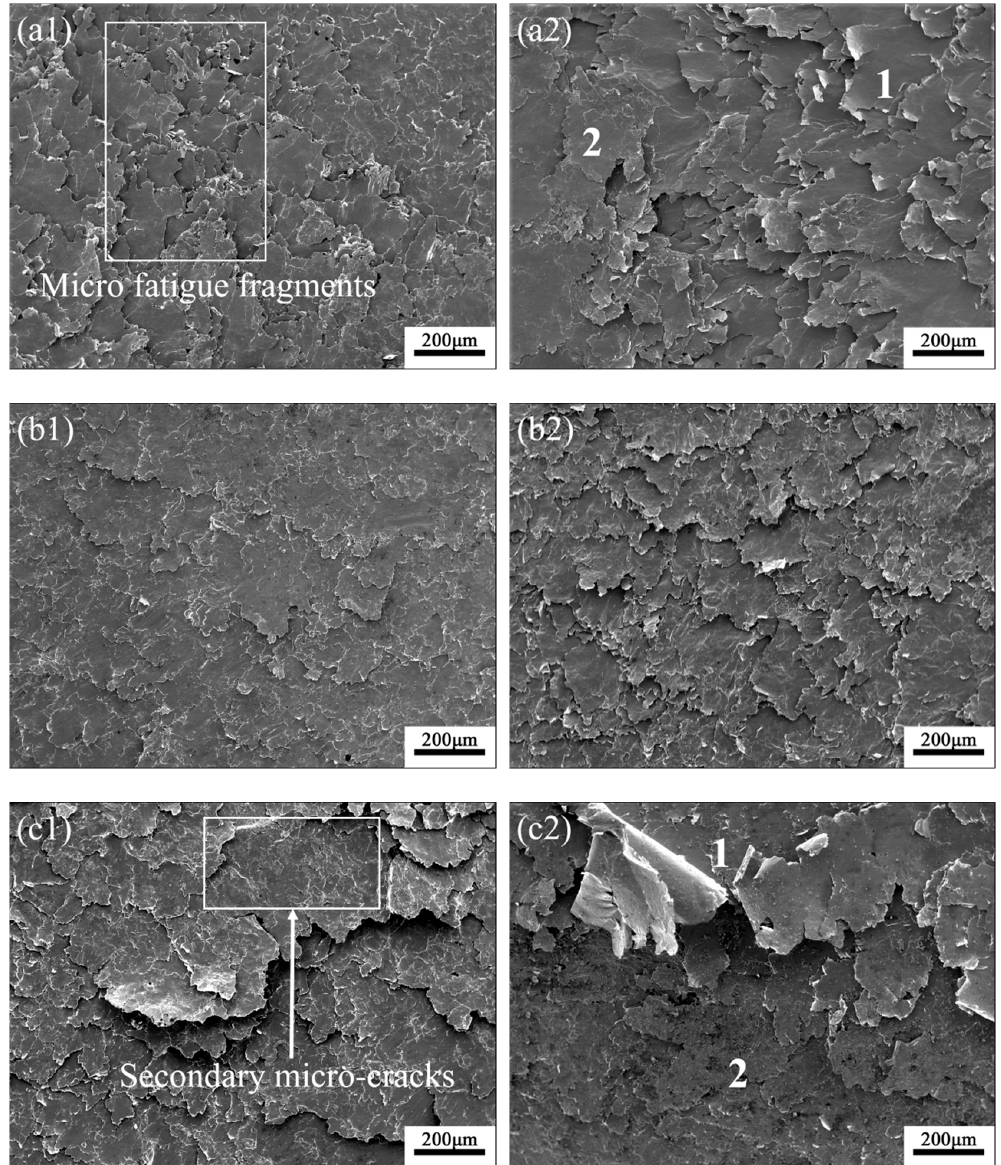
Figure 5. Worn surface morphologies of the tempered steels, ( a1 ) 300 ◦ C / 60 min and ( a2 ) 300 ◦ C / 120 min; ( b1 ) 550 ◦ C / 60 min and ( b2 ) 550 ◦ C / 120 min; ( c1 ) 680 ◦ C / 60 min and ( c2 ) 680 ◦ C / 120 min.